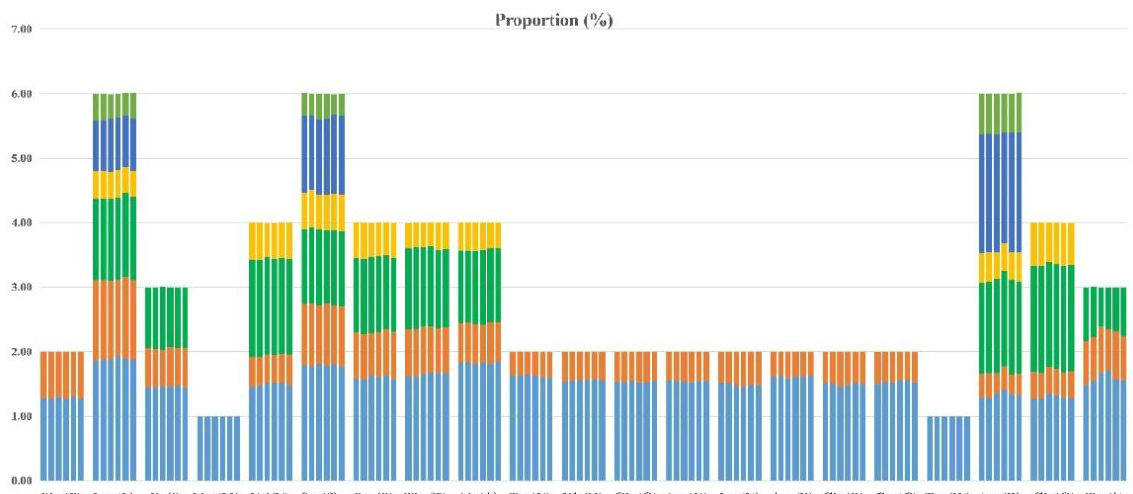
Figure 5. Amino acid proportion in protein-coding sequences among six chloroplast genomes in Ericales order. The histogram from the left-hand side of each amino acid shows codon usage bias (from left to right: C. fargesii , C. delavayi , S. tristyla , A. eriantha , S. japonicus , and S. superba ).